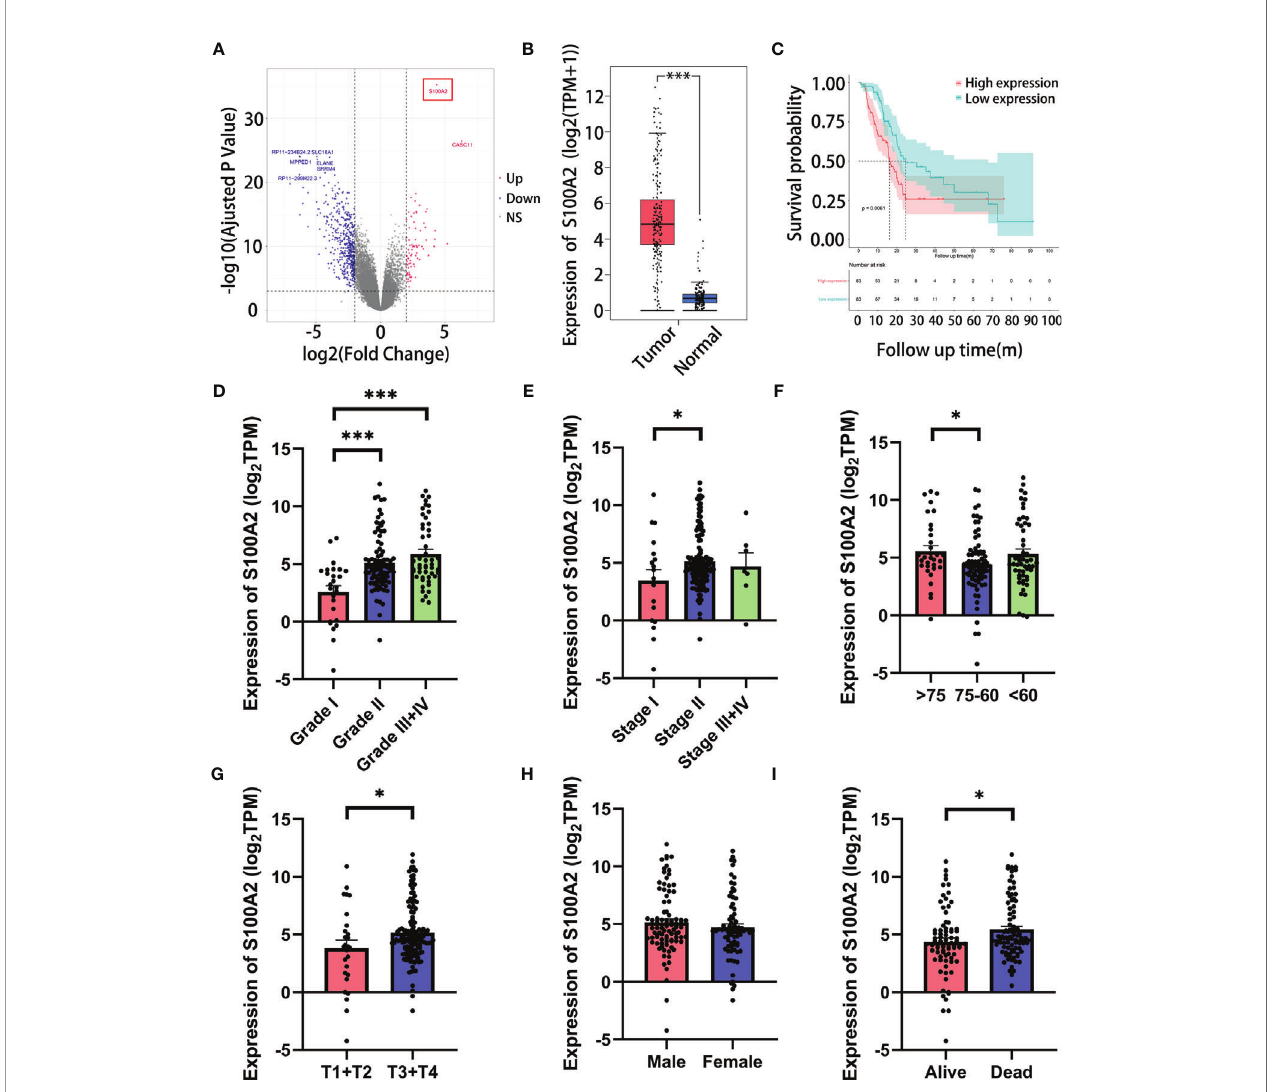
FIGURE 4 | The correlation of the expression of S100A2 and clinicopathological features of PC patients in TCGA entire set. (A) Screening out the most paramount gene in risk signature by DEGs analysis between high and low risk groups (the gene in red box). (B) Expression difference of S100A2 between PC tissue and normal tissue according to the cBioPortal database. (C) Kaplan-Meier analysis of OS between the high S100A2 expression group and low S100A2 expression group. (D – I) The correlation of S100A2 expression with clinicopathological features, including grade, AJCC_stage, age, T stage, N stage and status. *P < 0.05;